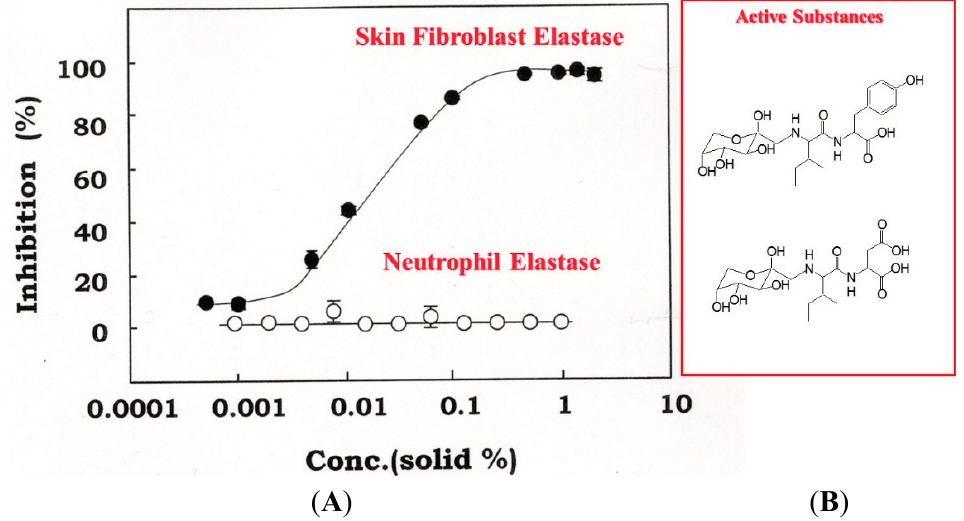
Figure 11. Concentration-dependent inhibition of skin fibroblast elastase by Zingiber officinale (L.) Rose ( A ) and chemical structures of active substances ( B ). An enzyme solution obtained from a cell lysate of human fibroblasts was used at a concentration of 200–500 μ g/mL. Fibroblast-derived elastase (filled circles) and neutrophil-derived elastase (open circles) activities were measured using STANA as a substrate in the presence of Zingiber officinale (L.) Rose at the indicated concentrations. Data represent means ±